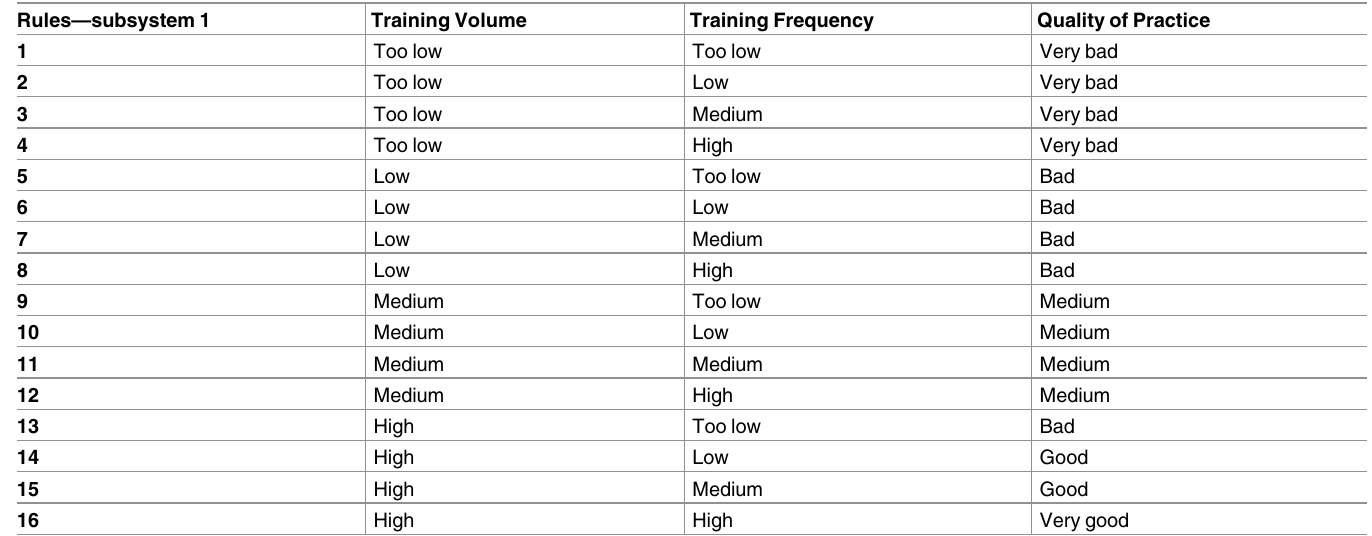
Table 1. Rules used in the subsystem1 –quality of